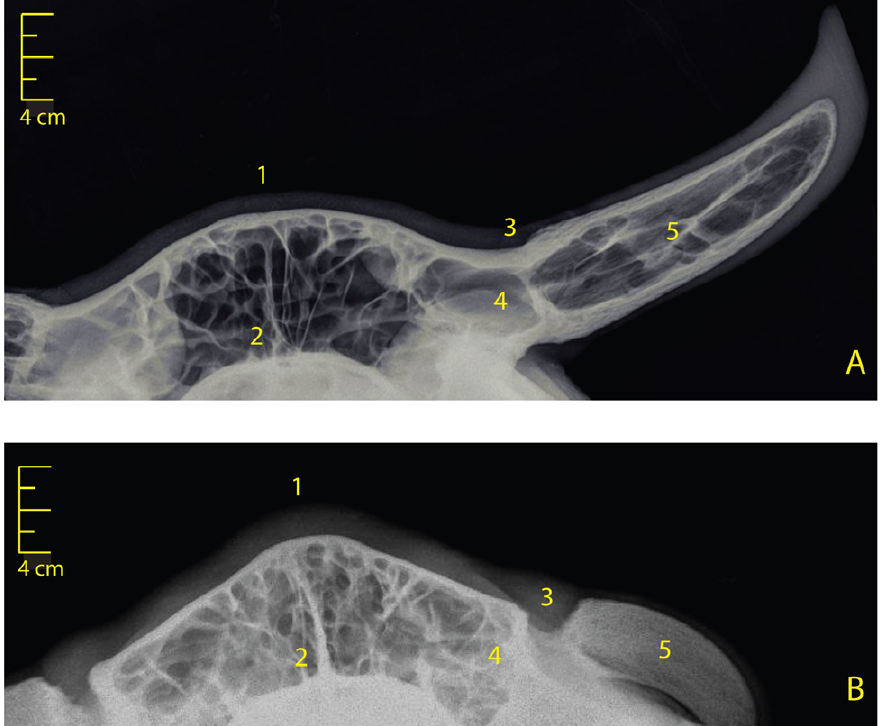
Figure 3. Frontal radiographs of type 2 scurred and horned skulls. (A). Control skull of a five-year old horned female. (B). Skull of a four-year old female affected by the type 2 scurs and carrying long scurs. Note: (1) the particular shape of the poll, (2) the denser calcification of the interfrontal suture, (3) the absence of fusion between the frontal bone and the horn bony core, (4) the absence of frontal bone drawing up and (5) the non- pneumatization of the bony core in affected vs. horned skulls.